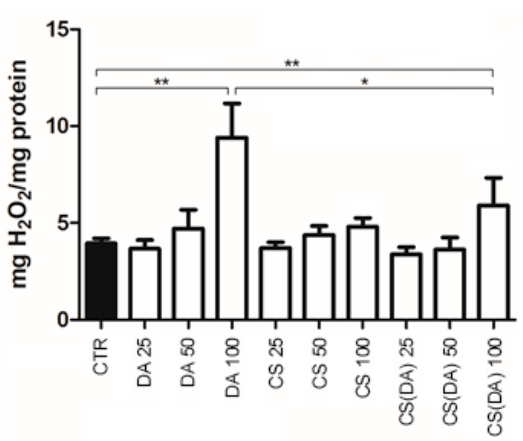
Figure 4. Amount of hydrogen peroxide produced by different incubated SH-SY5Y cell lines. Asterisks indicate statistical differences between the selected data series (* p < 0.05; ** p < 0.005).